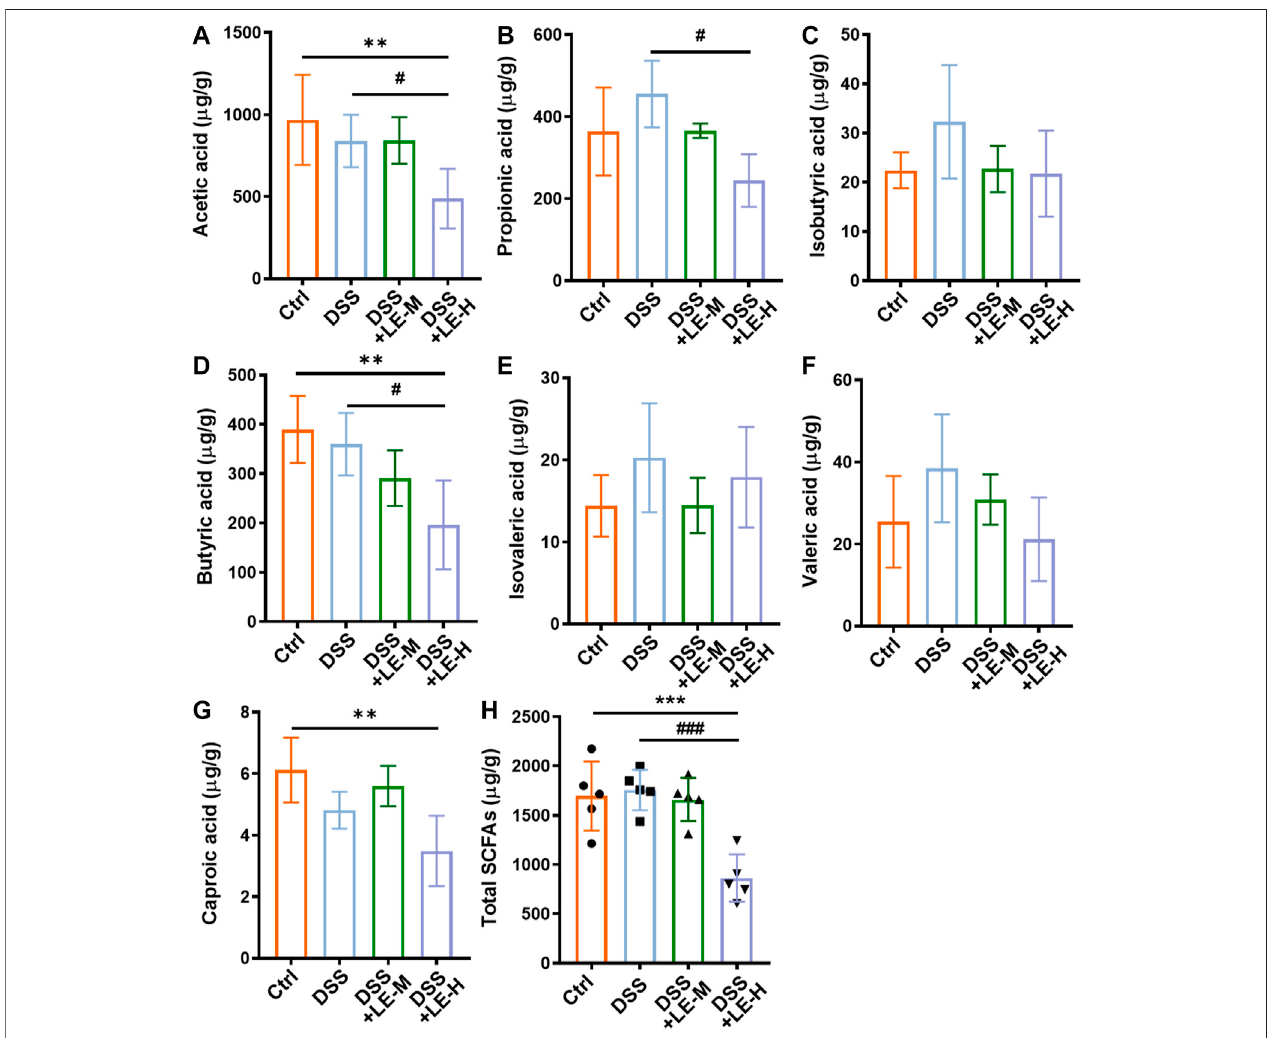
FIGURE 8 | Alteration of SCFA production in colitic mice supplemented with excessive longan. Contents of acetic acid (A) , propionic acid (B) , isobutyric acid (C) , butyric acid (D) , isovaleric acid (E) , valeric acid (F) , and caproic acid (G) in colonic contents. (H) Total contents of SCFAs. Data are presented as mean ± SD ( n (cid:1) 5). * p < 0.05, ** p < 0.01, *** p < 0.001, compared to Ctrl. # p < 0.05, ## p < 0.01, ### p < 0.001, compared to DSS